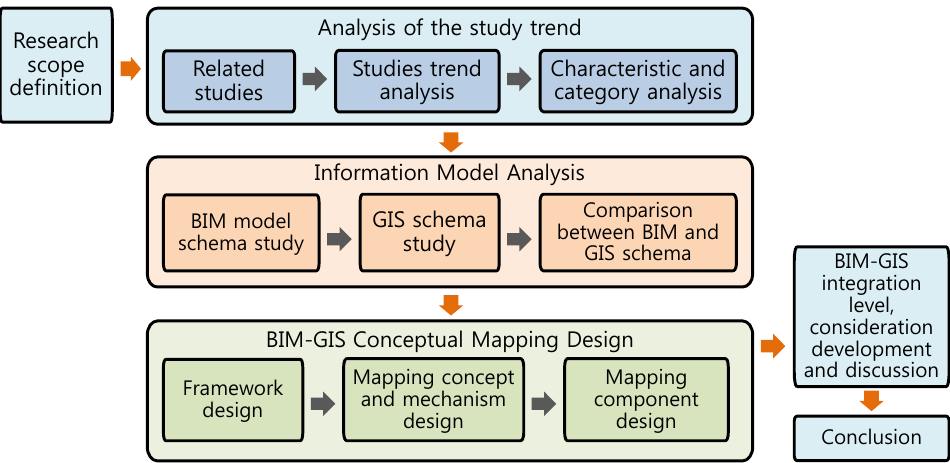
Figure 1. Research flow.